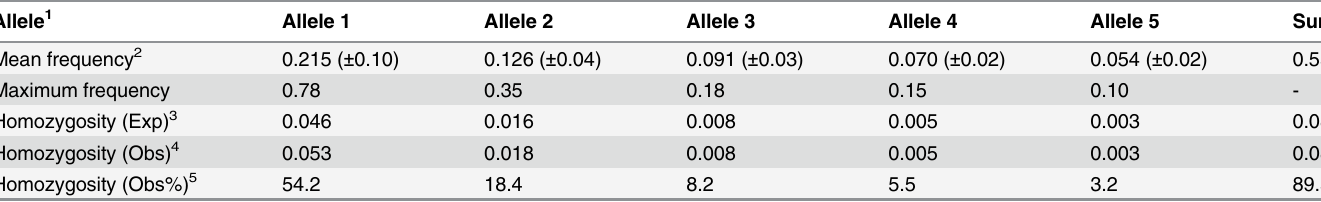
Table 3. Summary of the most frequent haplotypic allele using 50 SNP window. Allele